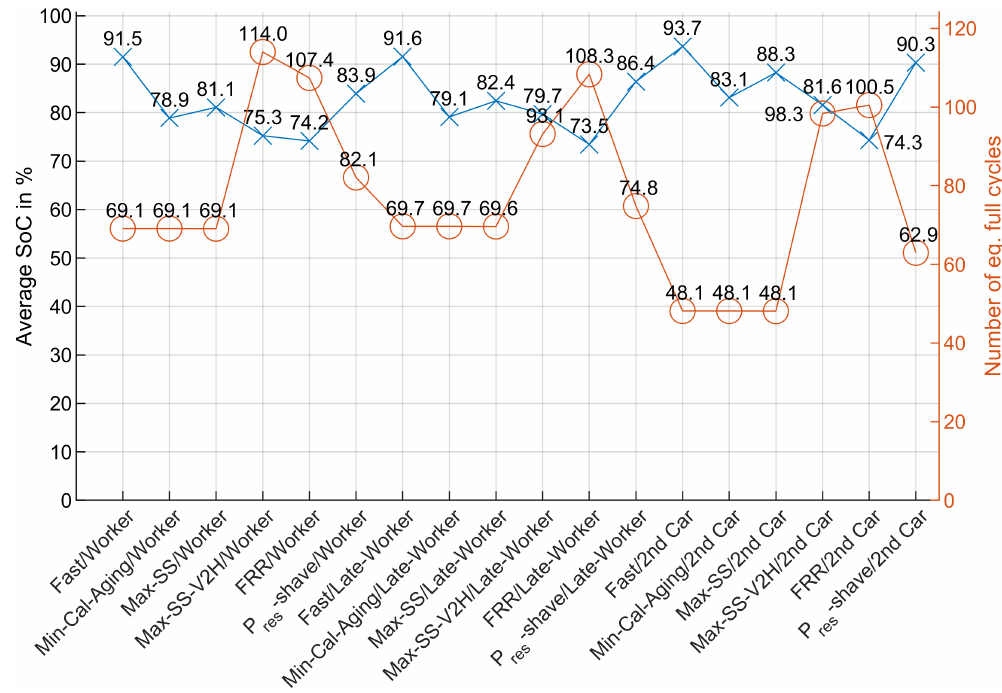
Figure A9. Average SoC and number of eq. full cycles for scenario home charging H and without